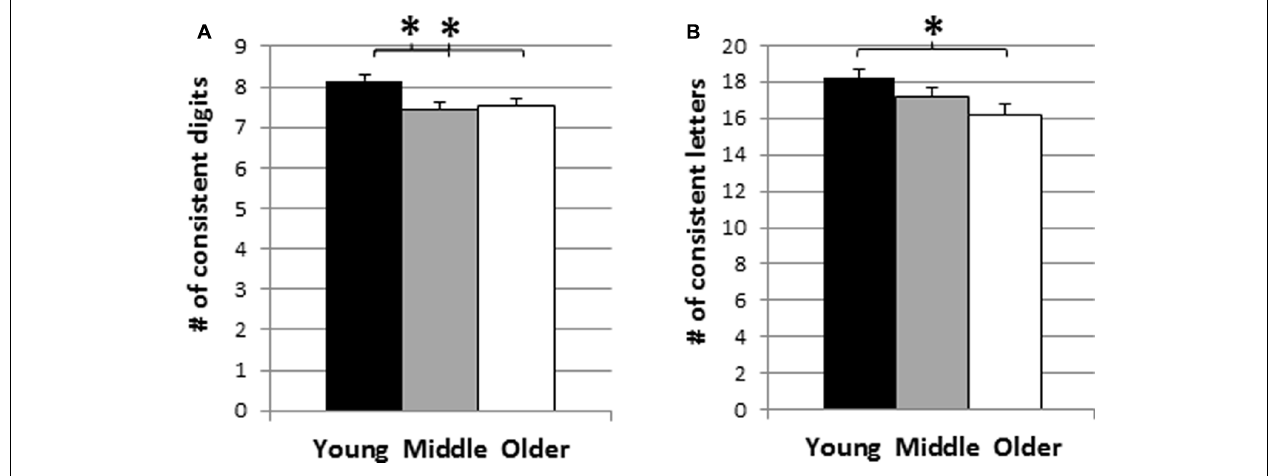
FIGURE 3 | Mean consistency scores across young (18–28 years), middle (29–42 years) and older adult age groups (43–91 years): (A) digits, (B) letters. * p < 0.05, # =